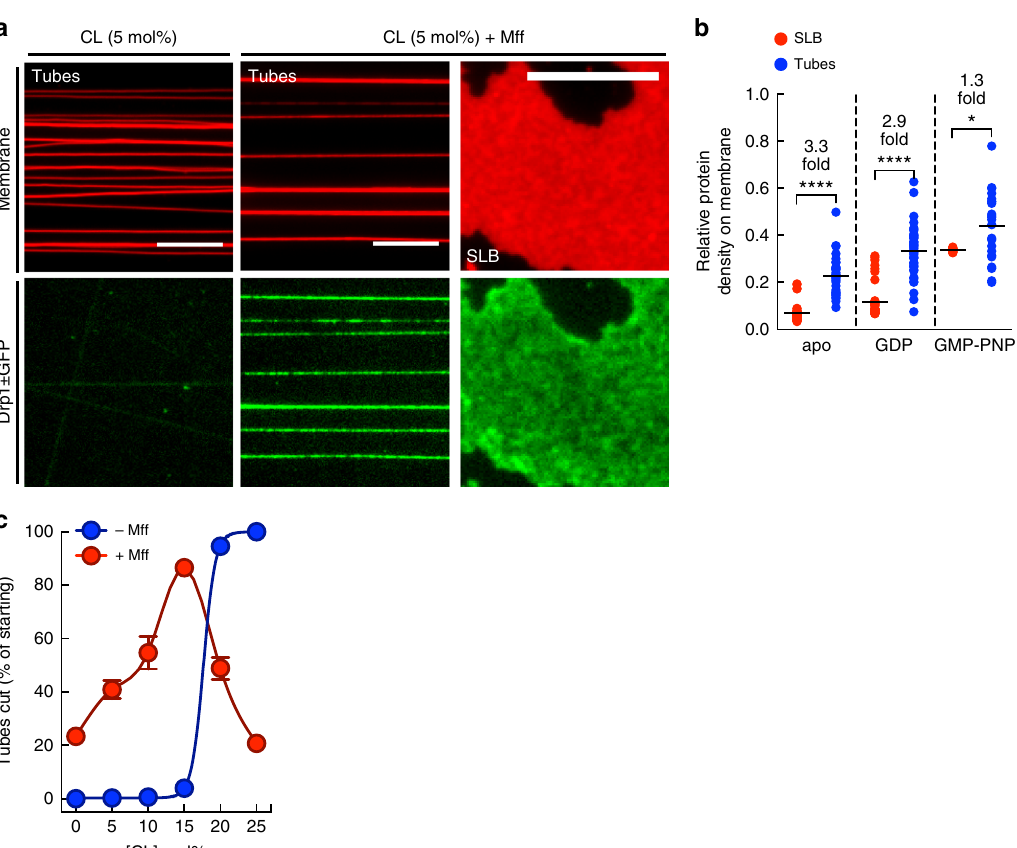
Fig. 8 Drp1-catalyzed fi ssion on compositional mimics of the mitochondria and peroxisomes. a Representative images of Drp1 ± GFP on tubes and SLB with 5 mol% CL with and without Mff. Scale bar = 10 µ m. b Ratios of Drp1 ± GFP and membrane fl uorescence on the SLB and tubes; **** p < 0.0001, * p = 0.013, Mann – Whitney ’ s test. n (SLB) = 40 and n (tube) = 32 from a single experiment for apo. n (SLB) = 43 and n (tube) = 46 from a single experiment for GDP. n (SLB) = 27 and n (tube) = 23 from a single experiment for GMP-PNP. c Plot showing the percentage of tubes cut as a function of CL concentration on tubes with and without Mff. Data represents the mean ± S.E.M. of n (tubes) >50 for each